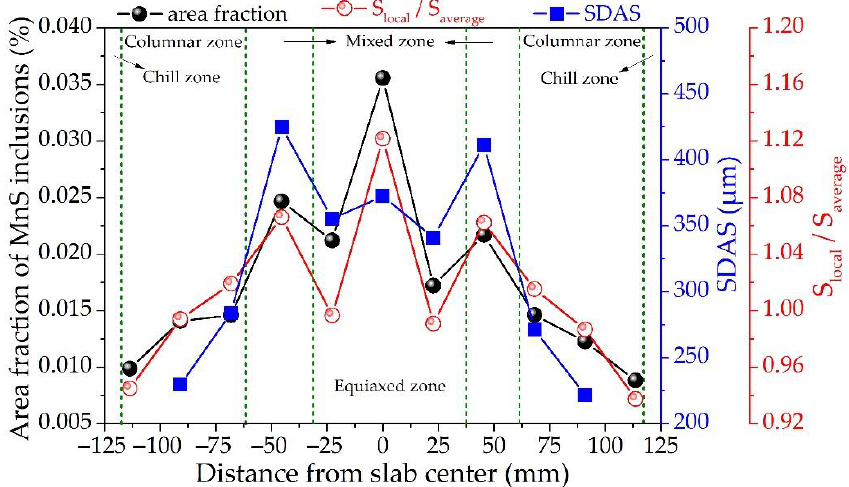
Figure 9. Distribution of MnS inclusions, sulfur segregation, and secondary dendrite arm spacings along the slab thickness of the medium carbon structural steel 45#.